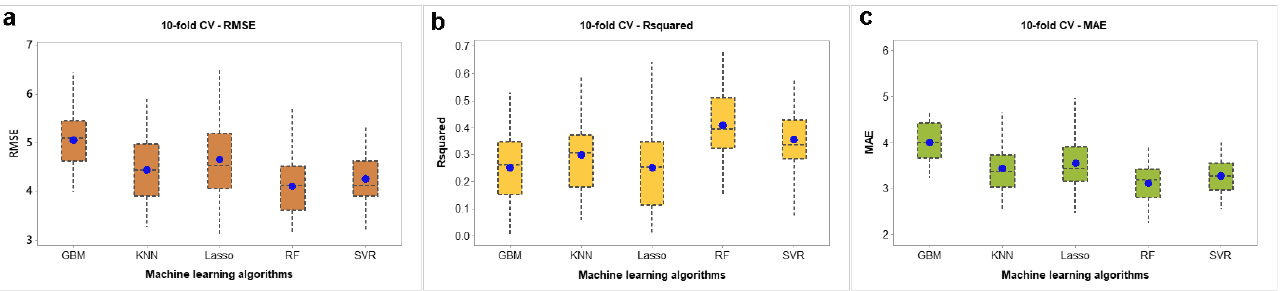
Figure 4. Comparison of model evaluation parameters: ( a ) root mean square error (RMSE), ( b ) coefficient of determination (R 2 ), ( c ) mean absolute error (MAE). Calculations were performed over 10 iterations. Table 3. Evaluation criteria for the machine learning algorithms included root mean square error (RMSE), mean absolute error (MAE), and R-squared (R 2 ) values.